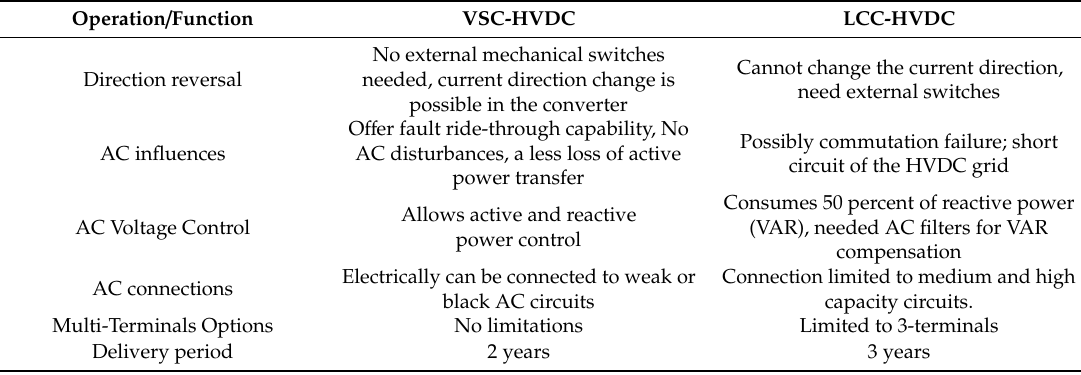
Table 2. Comparison of VSC-HVDC and